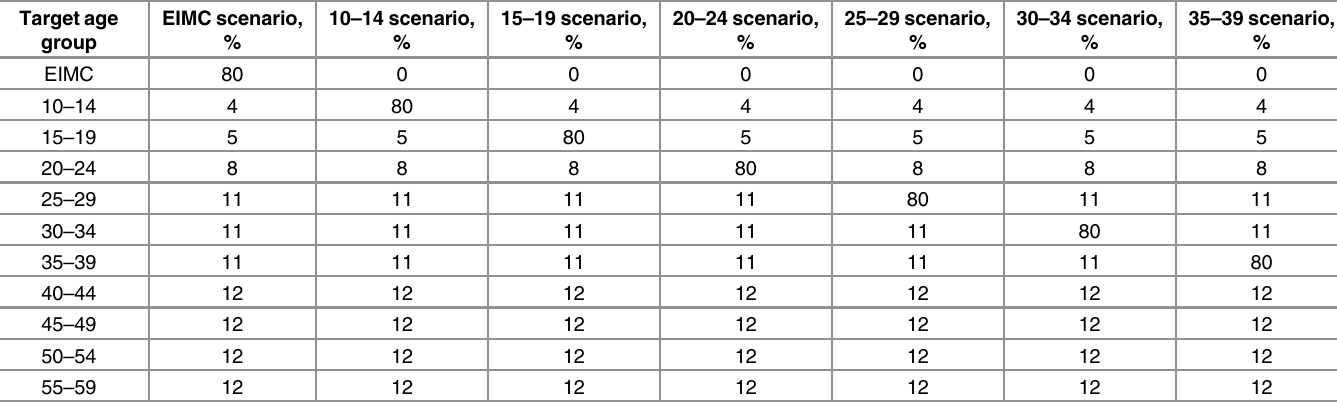
Table 1. Client Age-group Scenarios Used to Examine Impact of VMMC